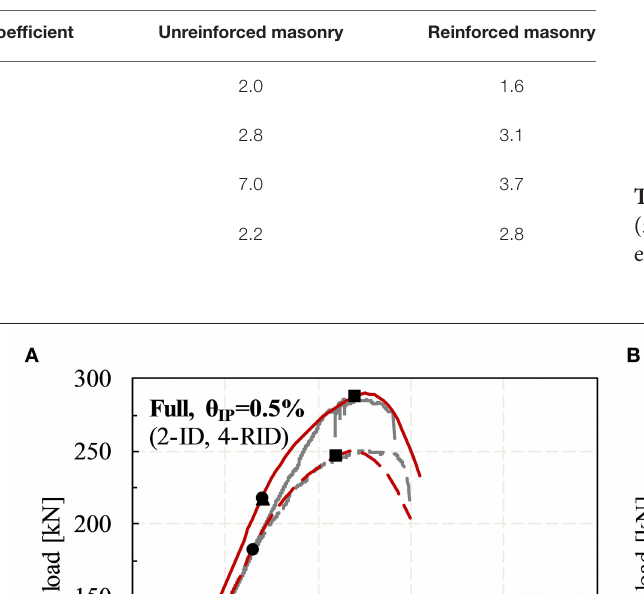
Frontiers in Built Environment |